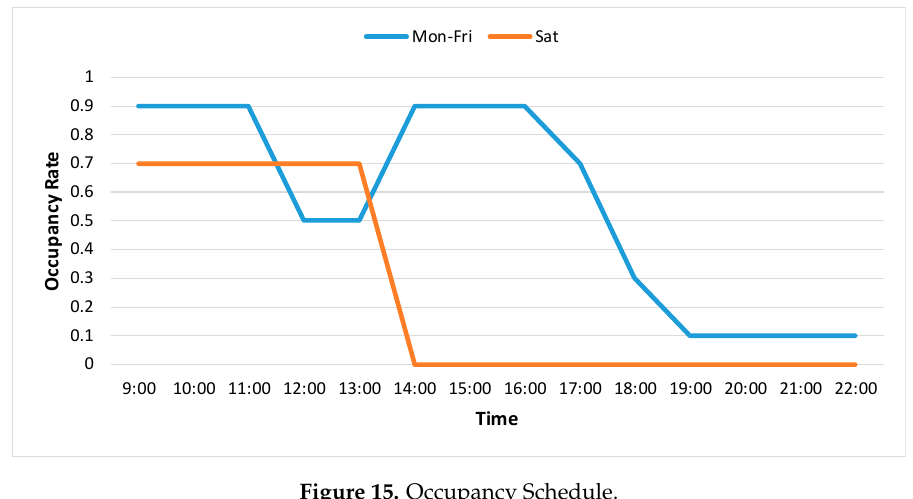
Figure 15. Occupancy Schedule.